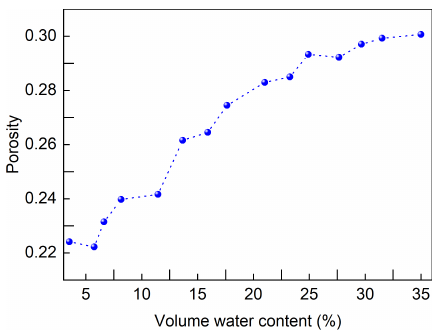
Figure 2. Shrinkage curve of the test